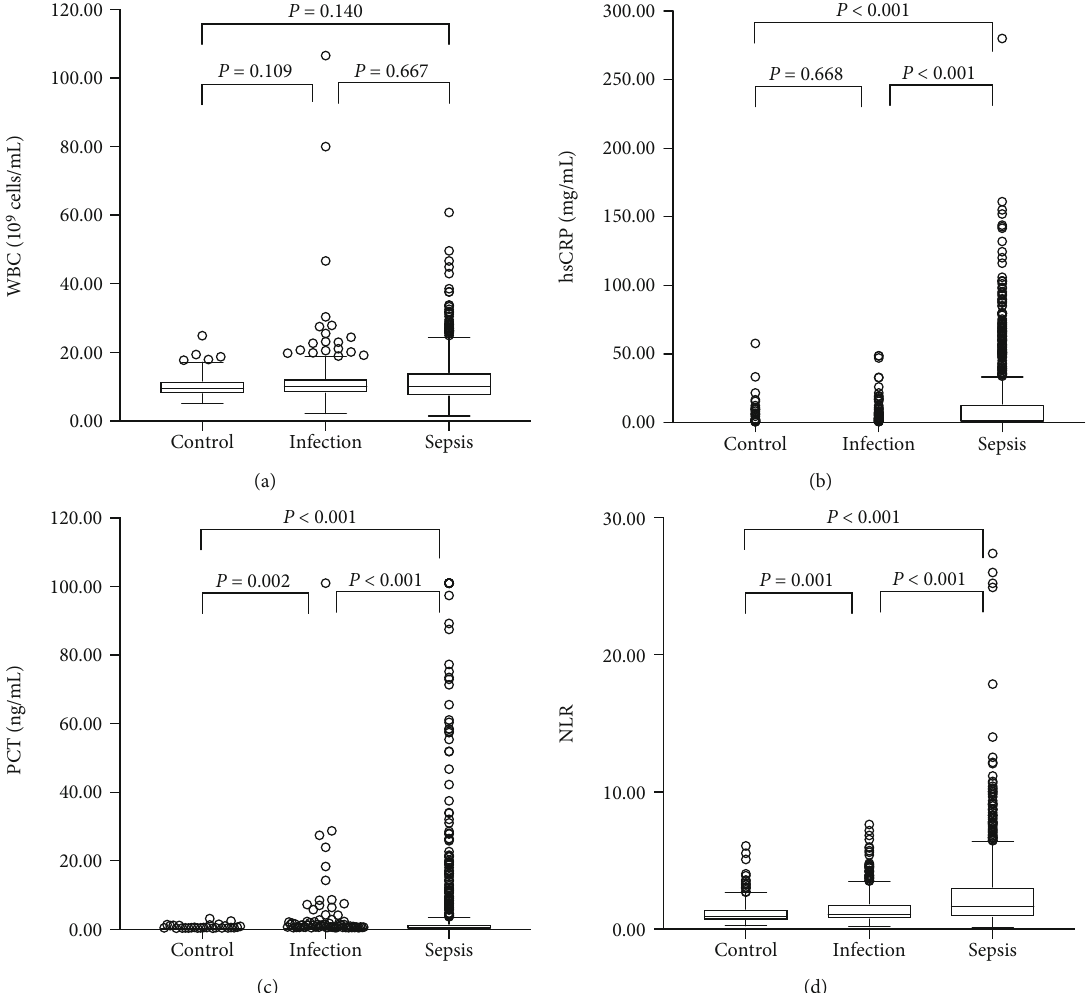
Figure 1: The levels of NLR and other in fl ammatory markers in control, infection, and sepsis group. (a) WBC had no signi fi cant di ff erence among 3 groups. (b) hsCRP signi fi cantly increased in neonates with sepsis. (c, d) PCT and NLR showed a gradual increase among 3